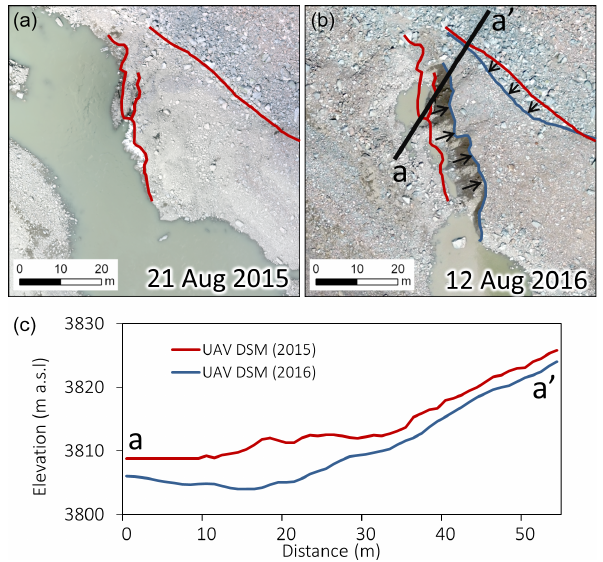
Figure 9. Surface features and elevation profiles of the debris- covered stagnant ice at the entrance of the outlet ice tunnel based on UAV orthoimages. (a) On 21 August 2015. Left red line shows the position of the exposed ice edge of the debris surface before the ice cliff underwent backwasting and melting. Right red line shows the deposition line of boulders on the slope. (b) Same as panel (a) except on 12 August 2016. The blue lines show the new positions of the respective surface features after 1 year. (c) Elevation profile of the surface along line a–a’ in panel (b) .